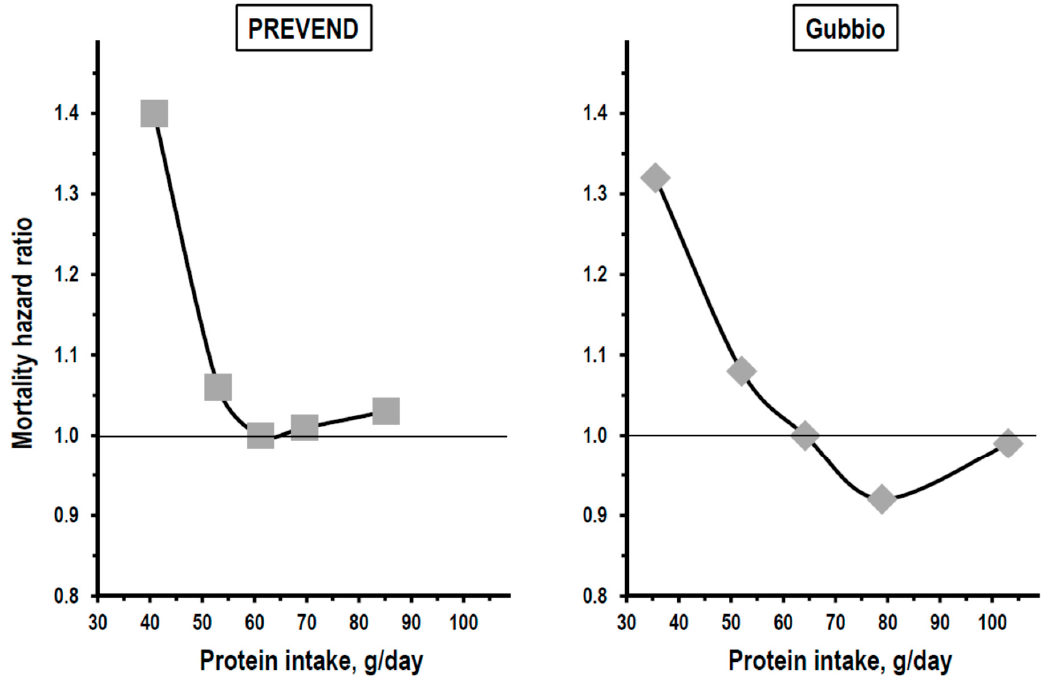
Figure 3. Relationships of baseline protein intake to long-term mortality in multivariate quintile analyses of the PREVEND study and the Gubbio study. Protein intake was assessed by urine urea nitrogen in both studies. Outcome of interest in vertical axis was the hazard ratio of all-cause mortality in both studies (thin line = mortality in quintile 3 as reference). Gray symbols are for data in the whole study cohort.